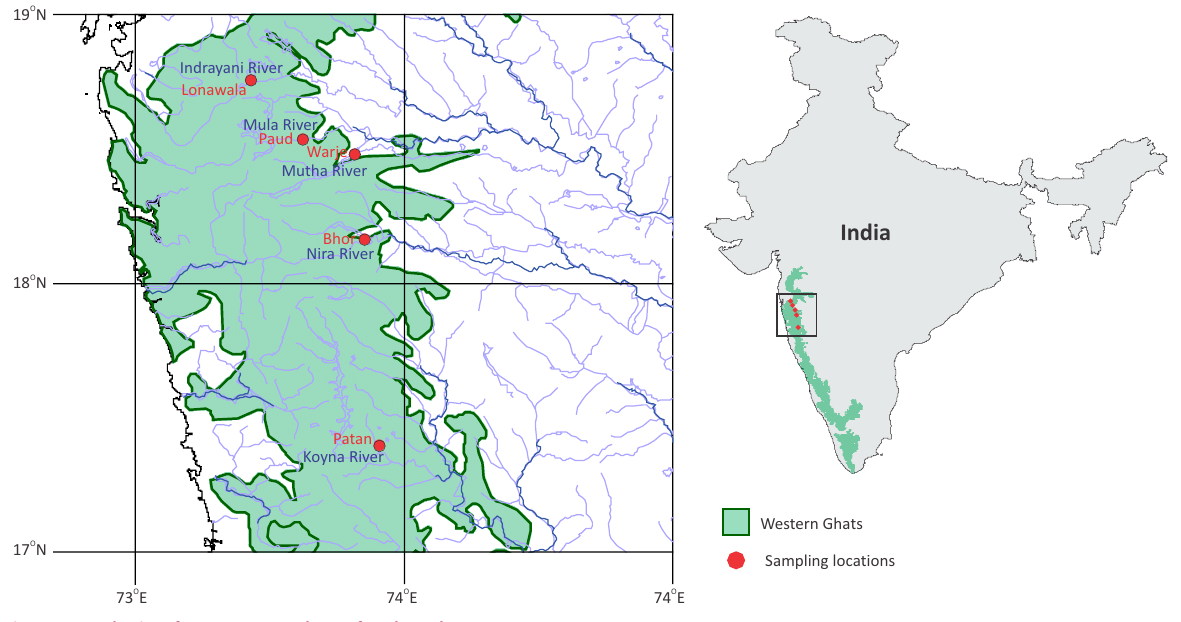
Figure 1. Study sites from Western Ghats of Maharashtra.